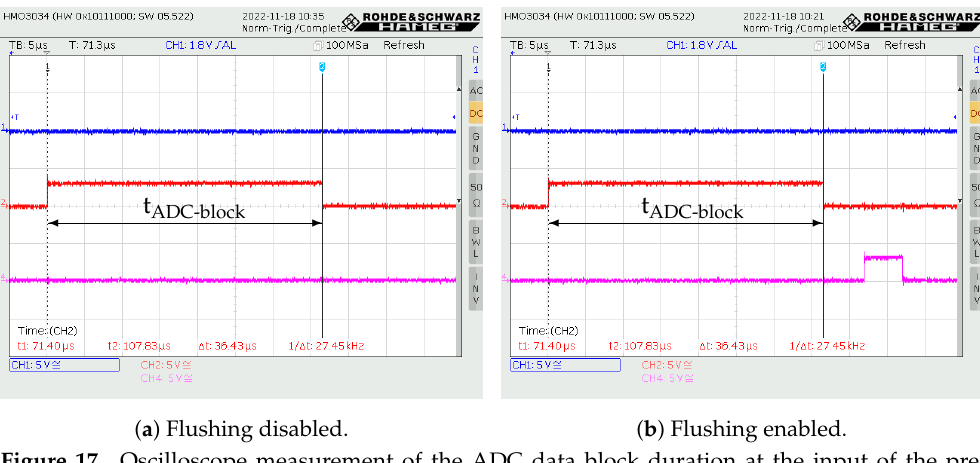
Figure 17. Oscilloscope measurement of the ADC data block duration at the input of the pre- processing block when the flushing is ( a ) disabled and ( b ) enabled. The upper signal is the SYNC_IN signal, the middle one is the S_IN signal, and the signal at the bottom is the S_OUT signal.